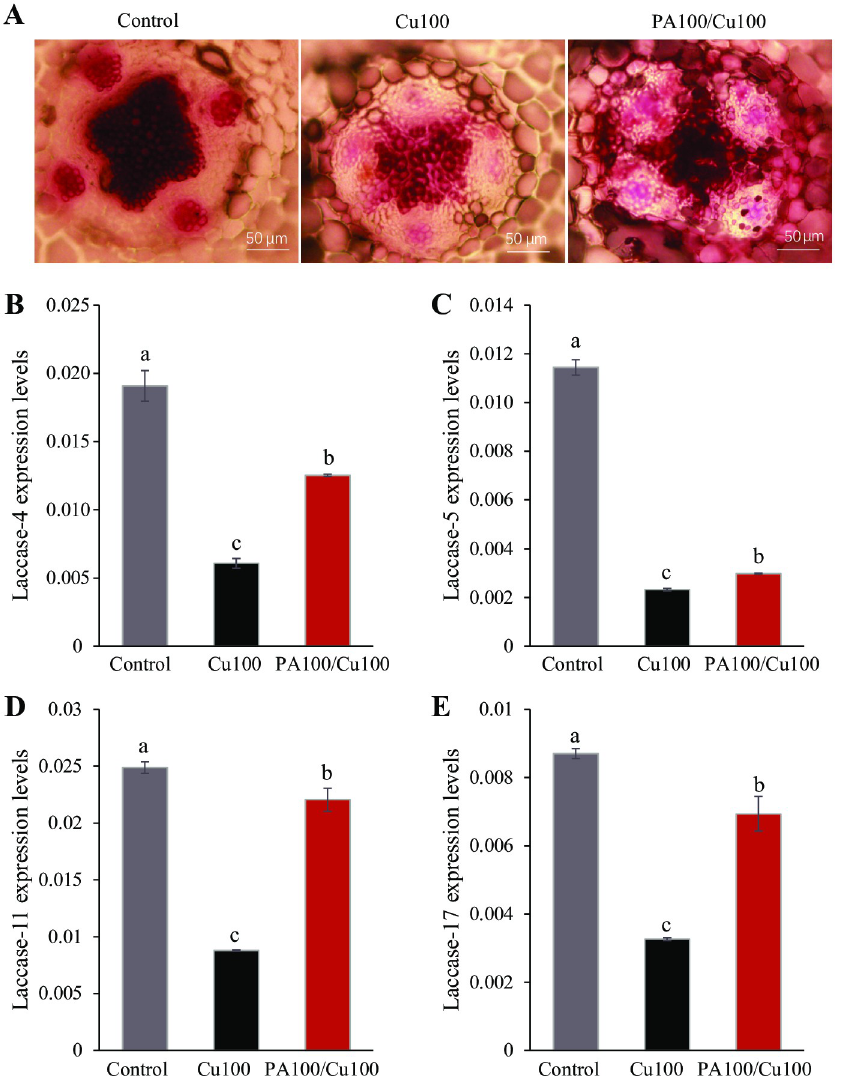
Fig 7. Proanthocyanidins (PAs) improved root lignin accumulation in R108 under Cu stress. (A) Phloroglucinol staining results of roots under Cu stress and PAs pretreatment. Transcriptional expression level of (B) MtrLAC-4, (C) MtrLAC-5, (D) MtrLAC-11, and (E) MtrLAC-17. PA100: 100 mg L -1 PAs pretreatment, Cu100: 100 mg L -1 CuSO 4 •5H 2 O. Means ± SE of three biological replicates. Significant differences (P � 0.05) are denoted by different lowercase letters.